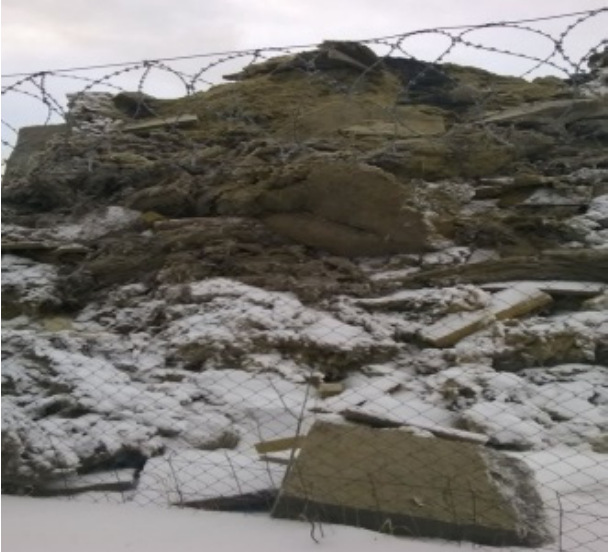
Figure 2. Waste production of basalt fiber insulation in a storage site.